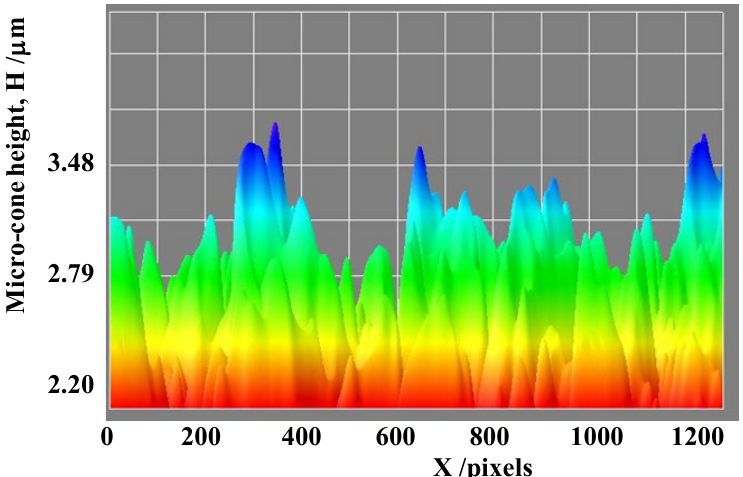
Figure 8. Local distribution of micro-cones in the LL-specimen, measured by SEM.